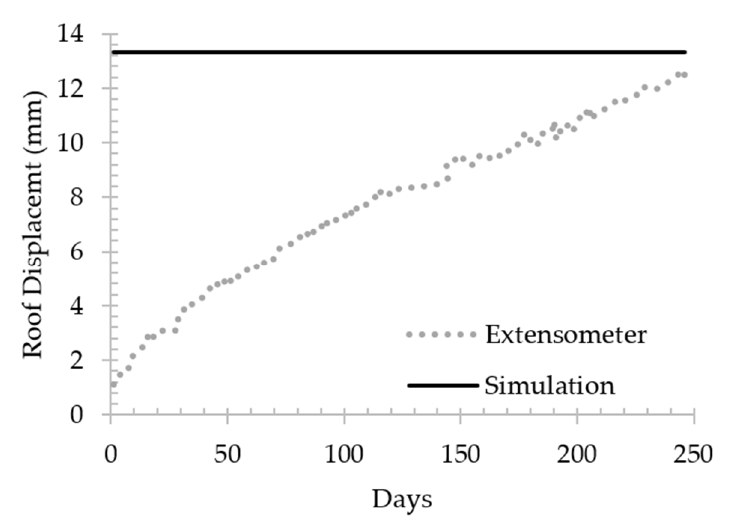
Figure 9. Comparison between extensometer results and simulation results.